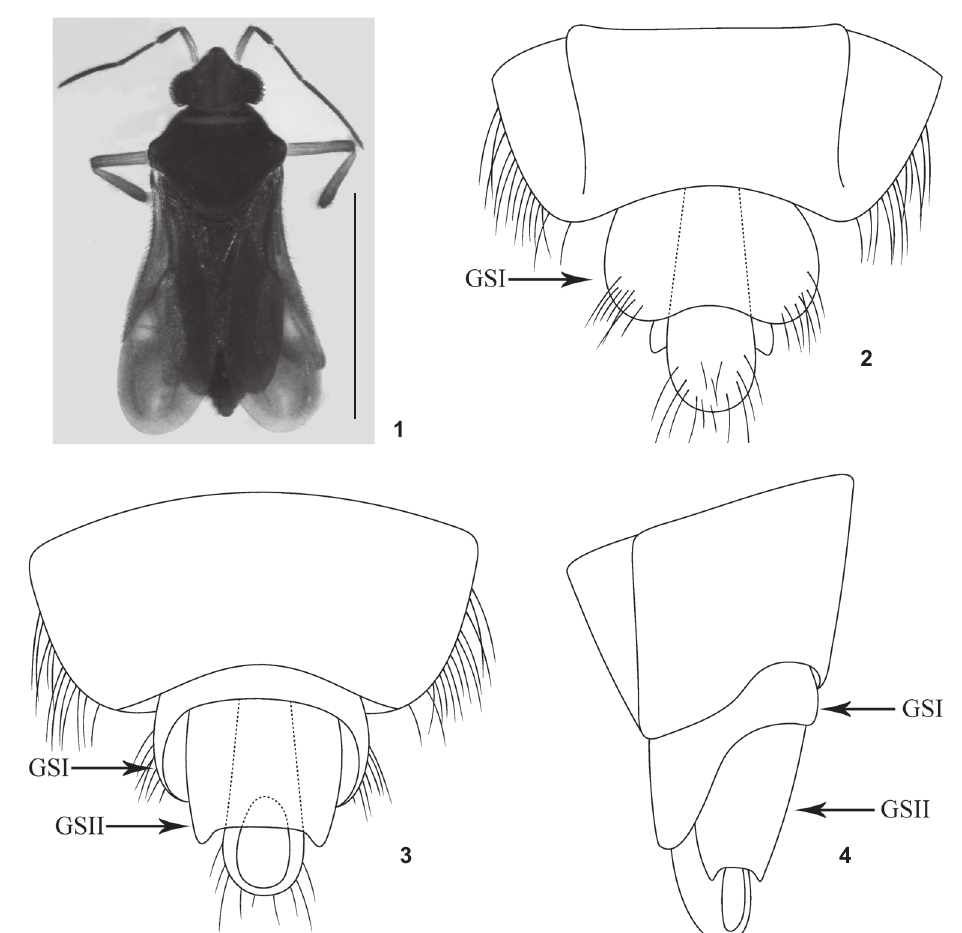
Figures 1-4. Microvelia urucara sp. nov. (1) macropterous male, dorsal view; and apex of abdomen and genital segments, male, in: